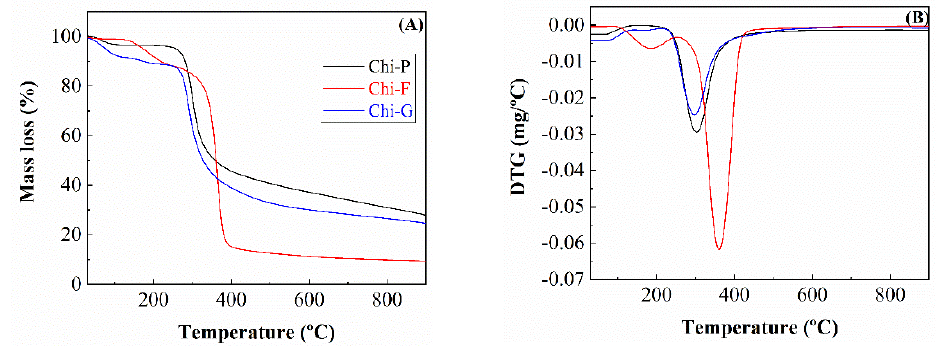
Figure 7. Thermogravimetric ( A ) and differential thermal analysis ( B ) of Chi-P, Chi-F and Chi-G precursors.